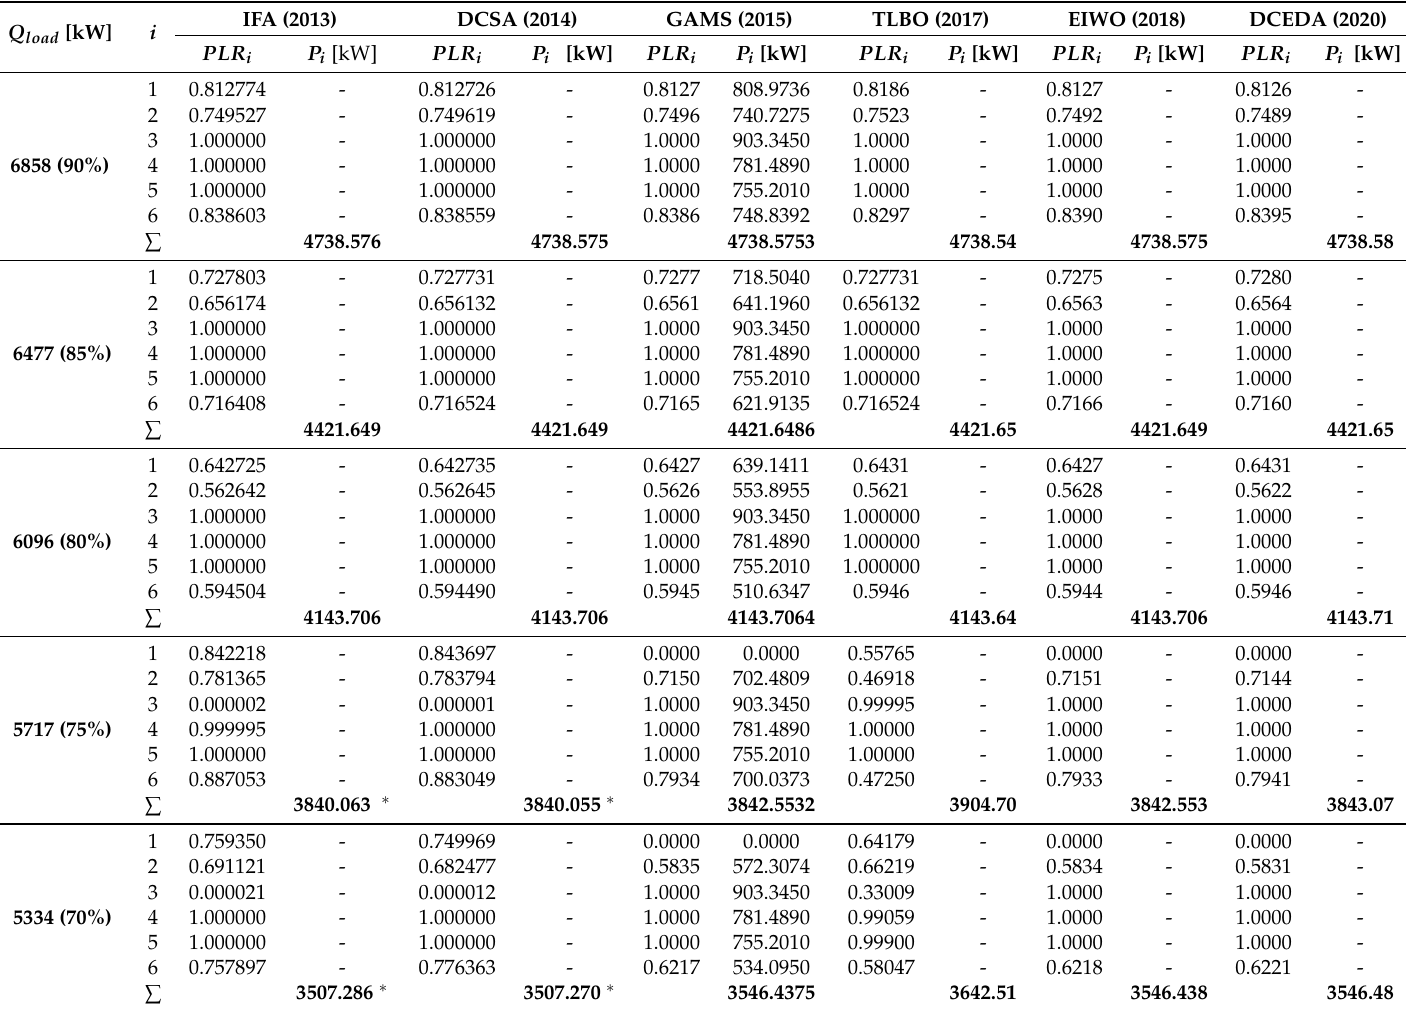
Table 1. Comparison of the results of IFA, DCSA, GAMS, TLBO, EIWO and DCEDA on Hsinchu